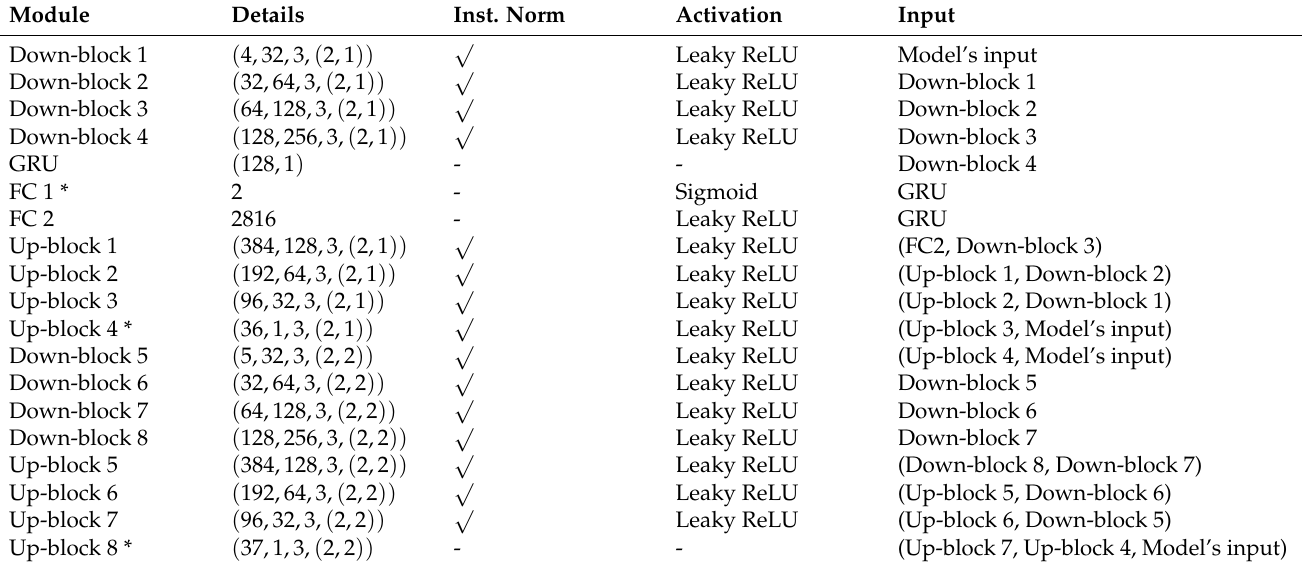
Table A1. Double-talk detection and spectrogram masking model specifications. Module names with an asterisk (*) are model outputs. For down-blocks and up-blocks, the numbers in the Details column represent input channels, output channels, kernel size, and stride of the convolution window or up-sampling factor, respectively. For the GRU layer, the Details column’s numbers represent hidden-layer size and number of layers, respectively. For fully-connected (FC) layers, the number represents the number of neurons. More than one module in the Input column means concatenation of the modules in